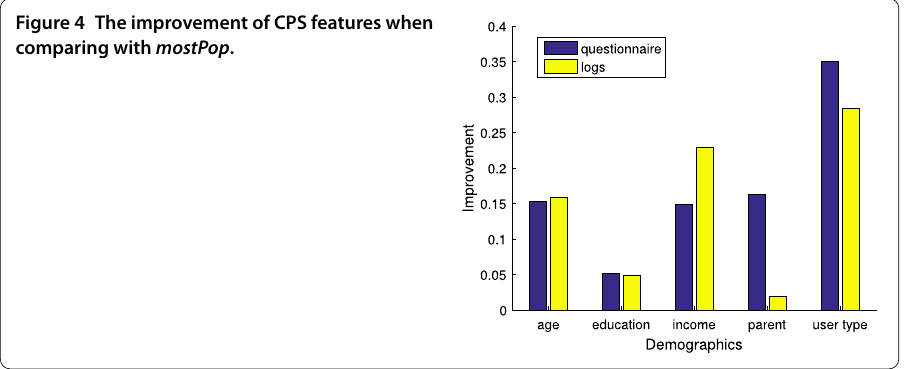
Figure 4 The improvement of CPS features when comparing with mostPop